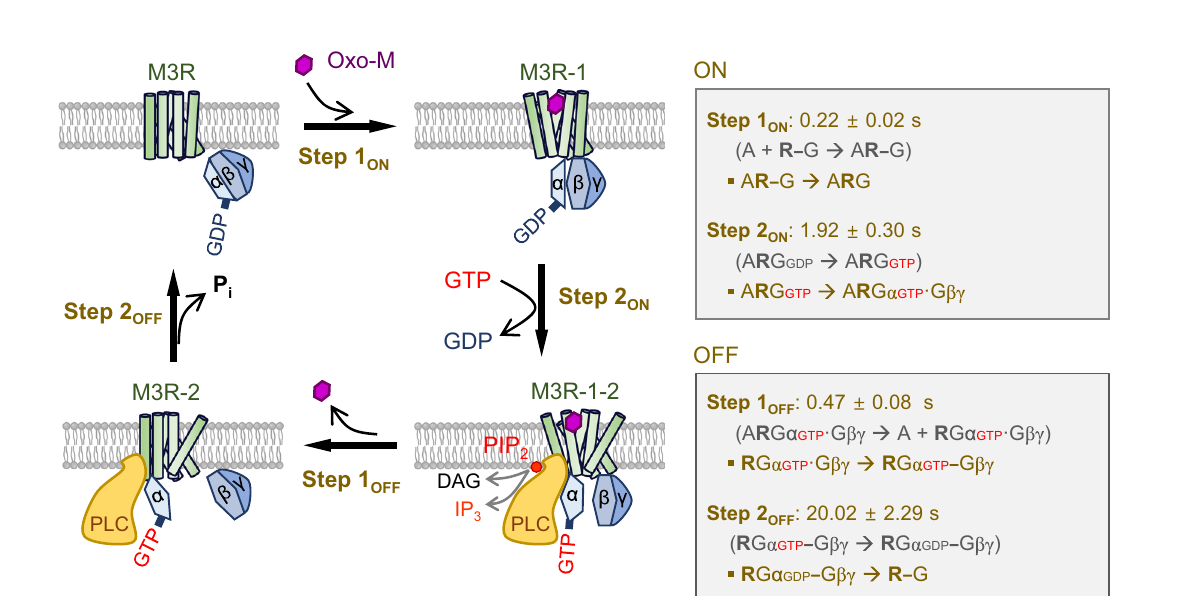
Fig. 8 | Schematic diagram of G q protein cycle-mediated conformational changes of hM3R. Cartoon depicts the effects of G q protein cycle on two-step activation and two-step deactivation of hM3R conformation. Boxes summarized theunderlyingprocessesofeachstep occurringduringONandOFFreactions.The reactions inthe parentheses werenot observed.The dash line (-) means a status of partial interaction or preassembly and a structural rearrangement by agonist